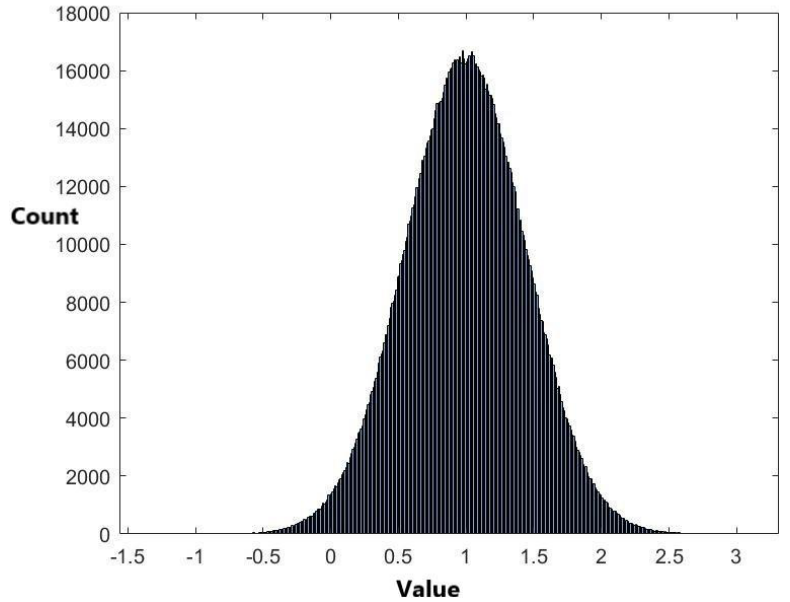
Figure 4. The histogram of 1,836,486 data generated from the fitted normal distribution.